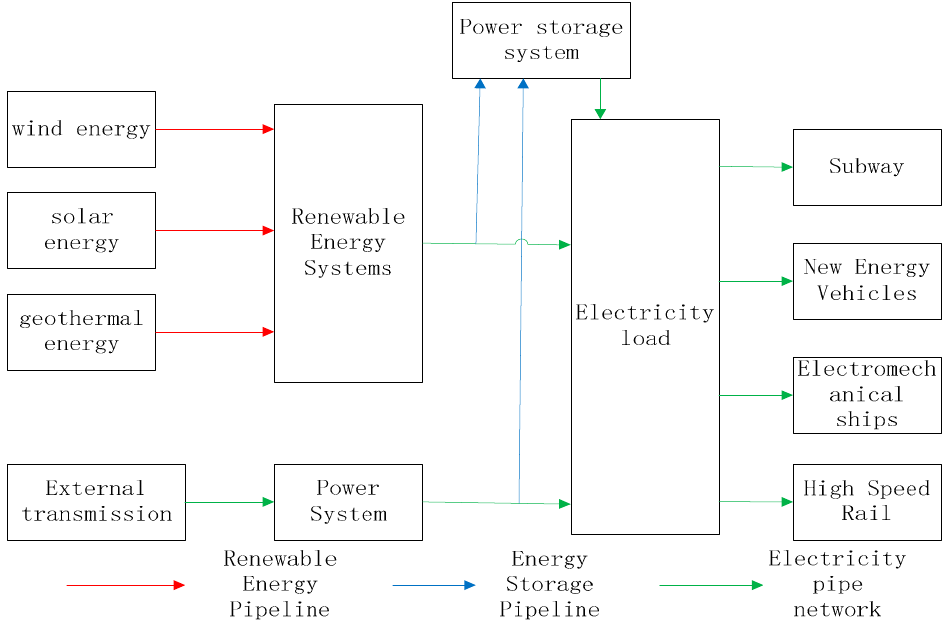
Figure 1. Transportation industry energy system structure diagram.